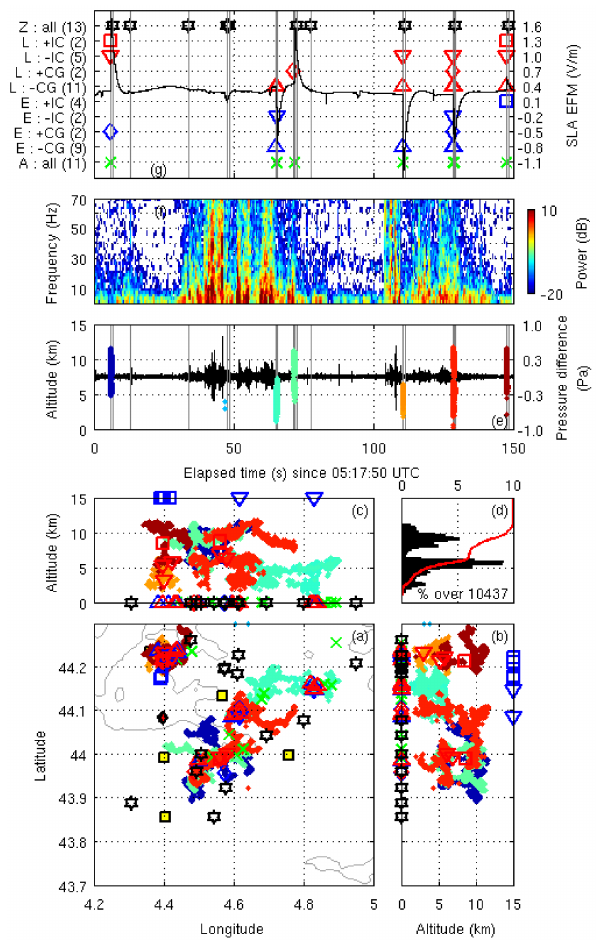
Figure 8. Coincident observations recorded between 05:17:50 and 05:20:20UTC on 24 September 2012 with (a) ground projection of the lightning records; (b) latitude–altitude projection of the lightning records; (c) longitude–altitude projection of the lightning records; (d) 250m increment histogram (bars) and cumulative dis- tribution (red cure) of the VHF source altitude; (e) time–height se- ries of VHF sources and pressure difference measured at the MPA location; (f) time series of the acoustic spectrum as recorded at MPA location; and (g) records of OLLSs per instrument with the time se- ries of the Uzès SLA